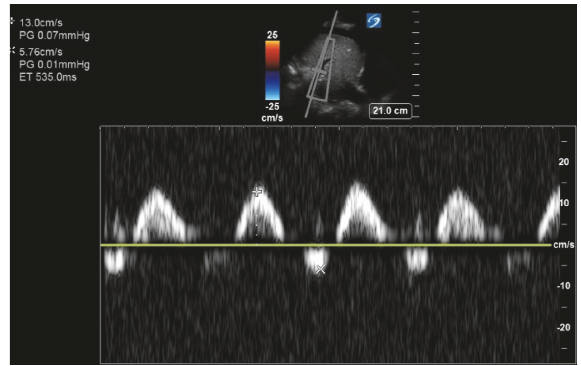
Figure 1: Portal vein Doppler exam performed 4hrs after ROSC on day 1. There is a biphasic portal vein profile with flow reversal. Max- imum and minimum velocities are 13 and 5.76 cm/s, respectively. Pulse is 85 beats per minute (bpm). Portal vein pulsatility fraction is greater than 100 %. Ascites is present.